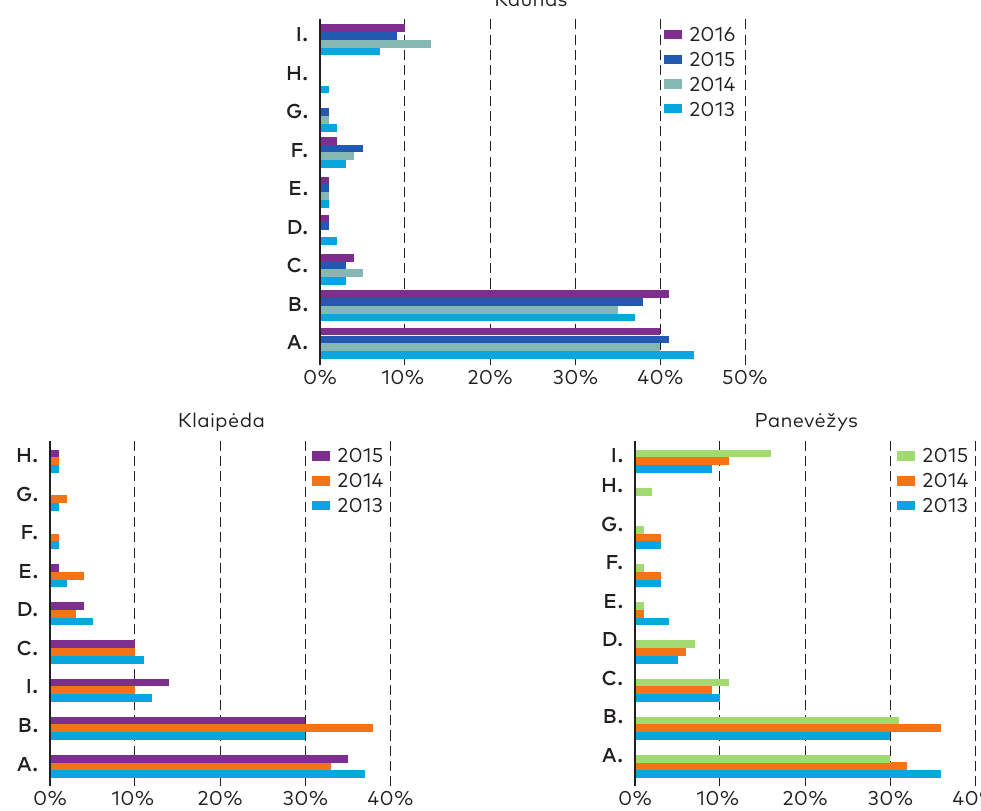
Figure 4. Statistics of traffic accidents by type. A – Motor V vs pedestrian; B – Motor V vs Motor V, C – Motor V vs bicycle, D – Rollover; E – Motor V vs standing Motor V, F – Driveway and obstacle; G – Motor V vs motorcycle; H – Motor V vs motorbike; I –